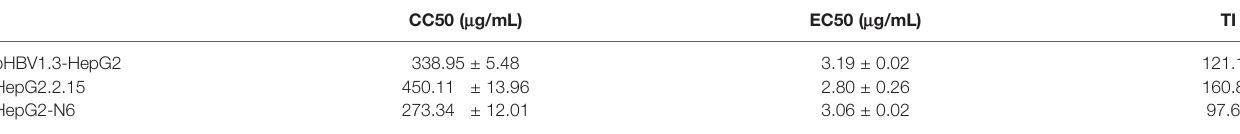
TABLE 2 | The cytotoxicity, ef fi cacy, and therapeutic index of liposomal